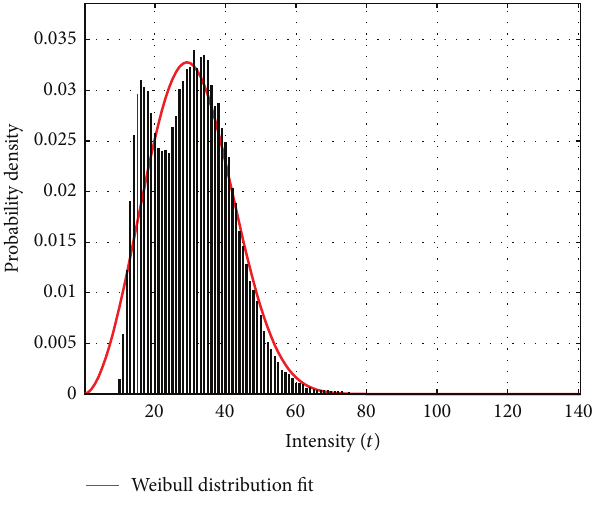
Figure 15: Histogram and curve fitting results for vehicle loads in the morning and the evening rush hour periods.